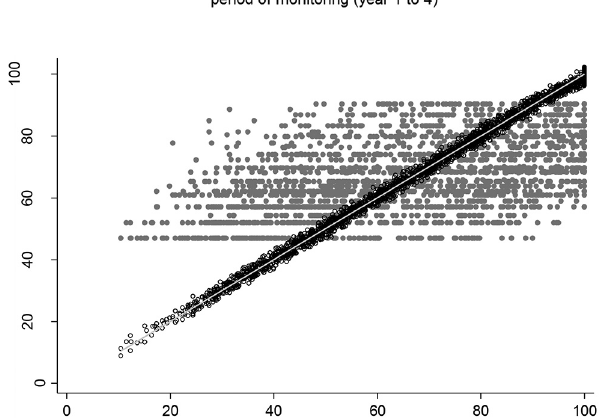
Figure 16. Predicted school performance values throughout time for the fi rst 50 students in the sample